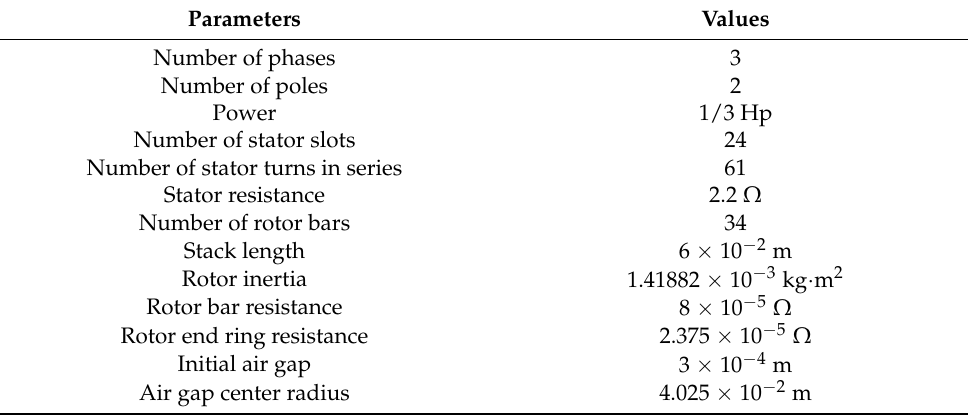
Table 2. MCC model parameters of the induction motor.